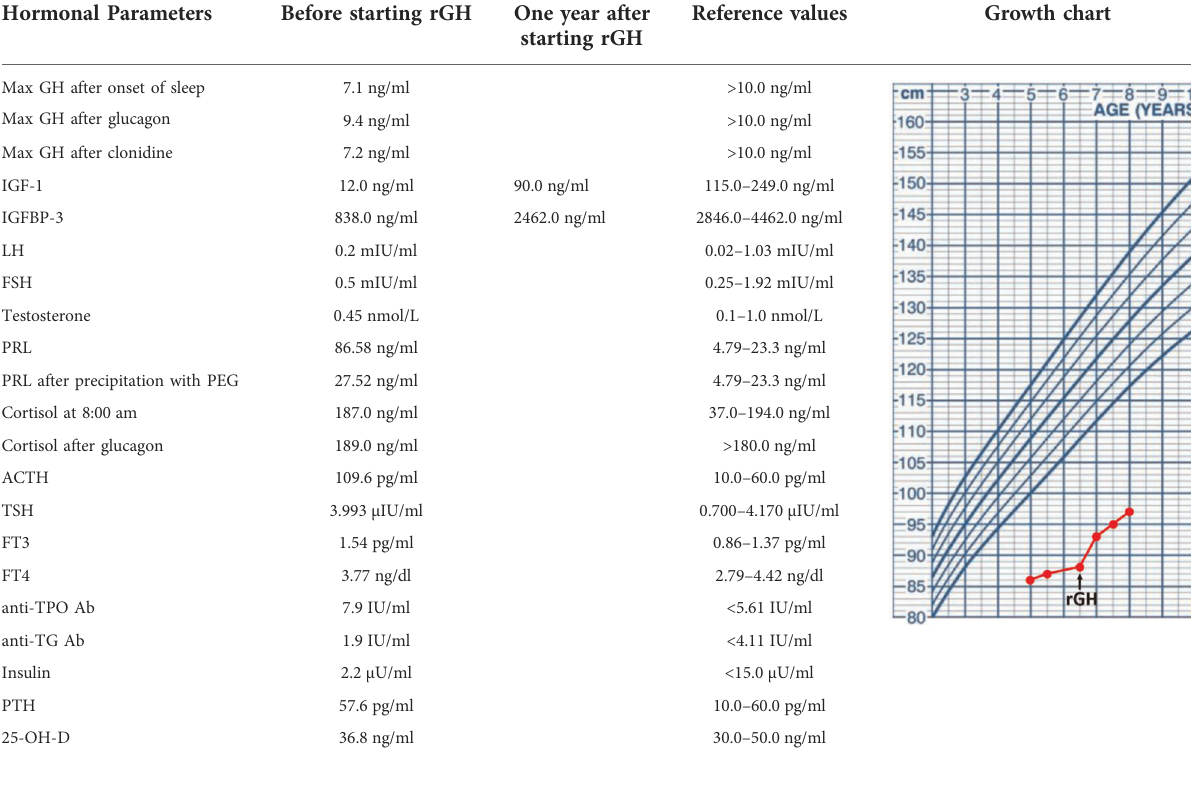
TABLE 2 Endocrinological workup of the presented CFCS patients before and one year after starting the rGH therapy, aged 6 and 7 years old, respectively. Hormonal